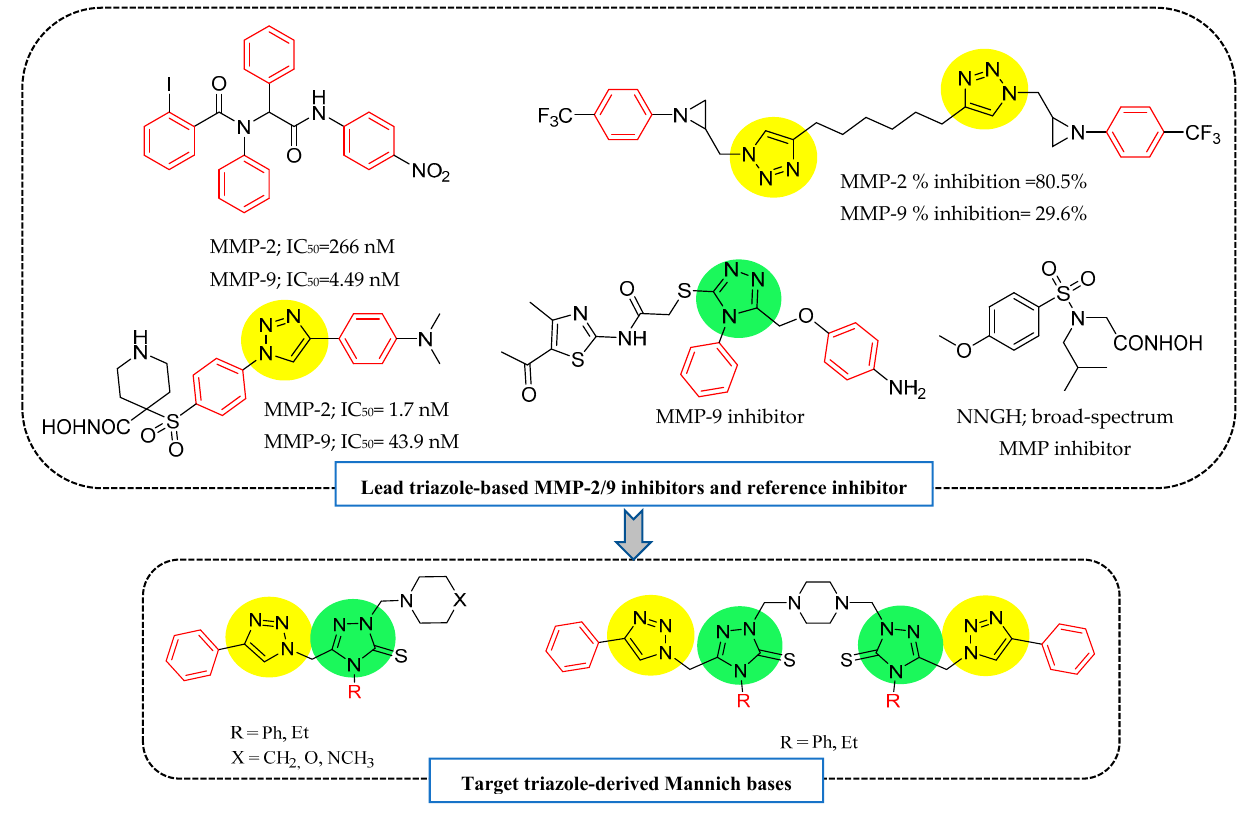
Figure 1. Lead and target MMP-2/9 inhibitors [28,49,50,54].